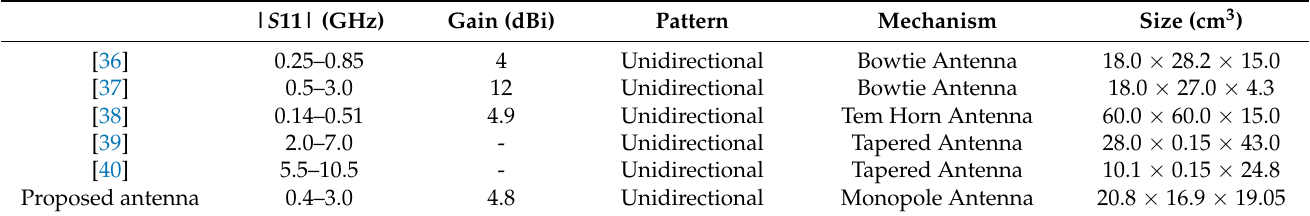
Table 1. Characteristic comparisons of the proposed antenna with